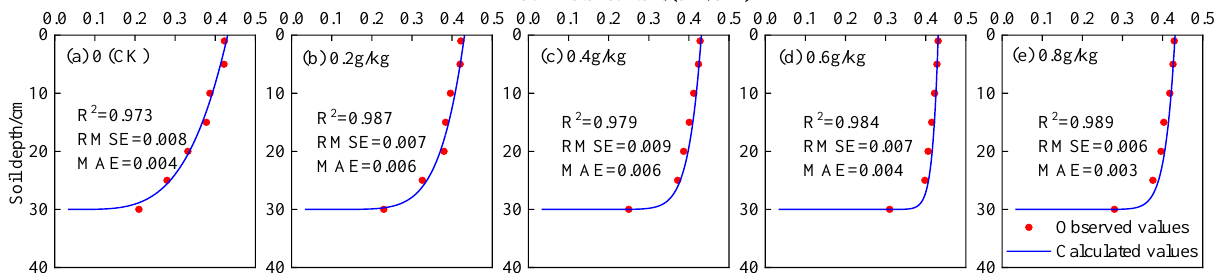
Figure 4. Comparison of the calculated and observed soil water content. ( a ) 0 (CK); ( b ) 0.2 g/kg; ( c ) 0.4 g/kg; ( d ) 0.6 g/kg; ( e ) 0.8 g/kg.